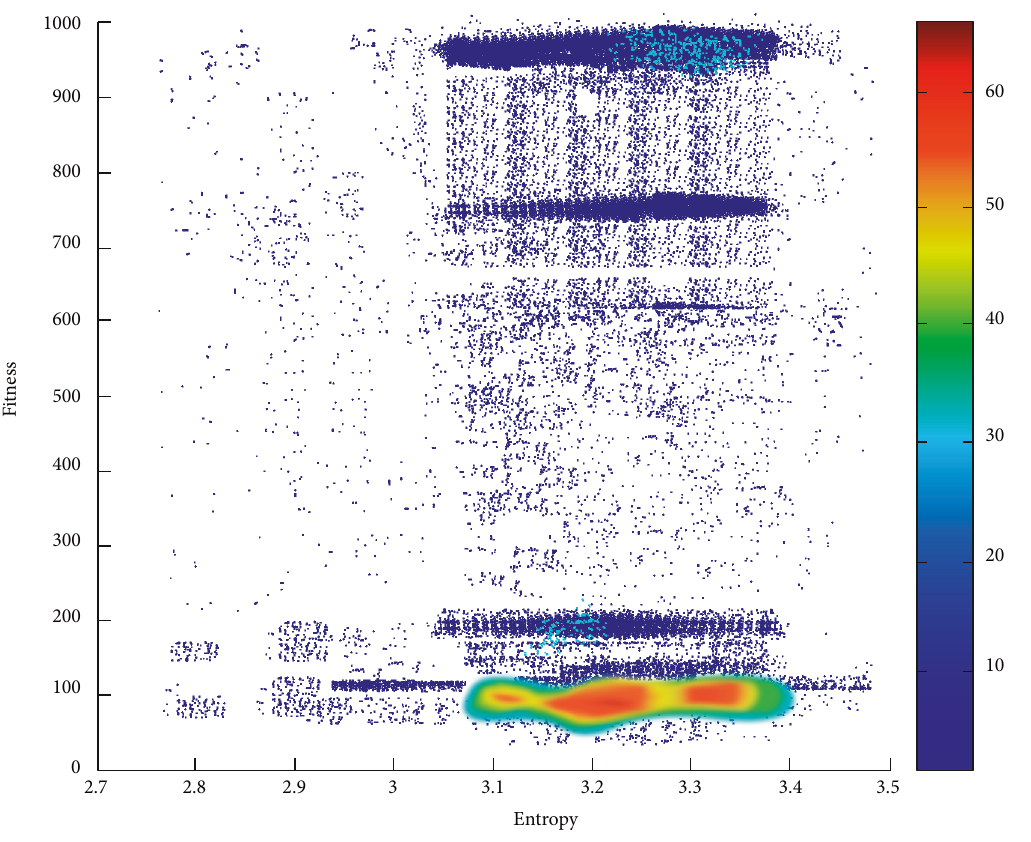
Figure 10: Entropy scatter density plot of earthquake time series.